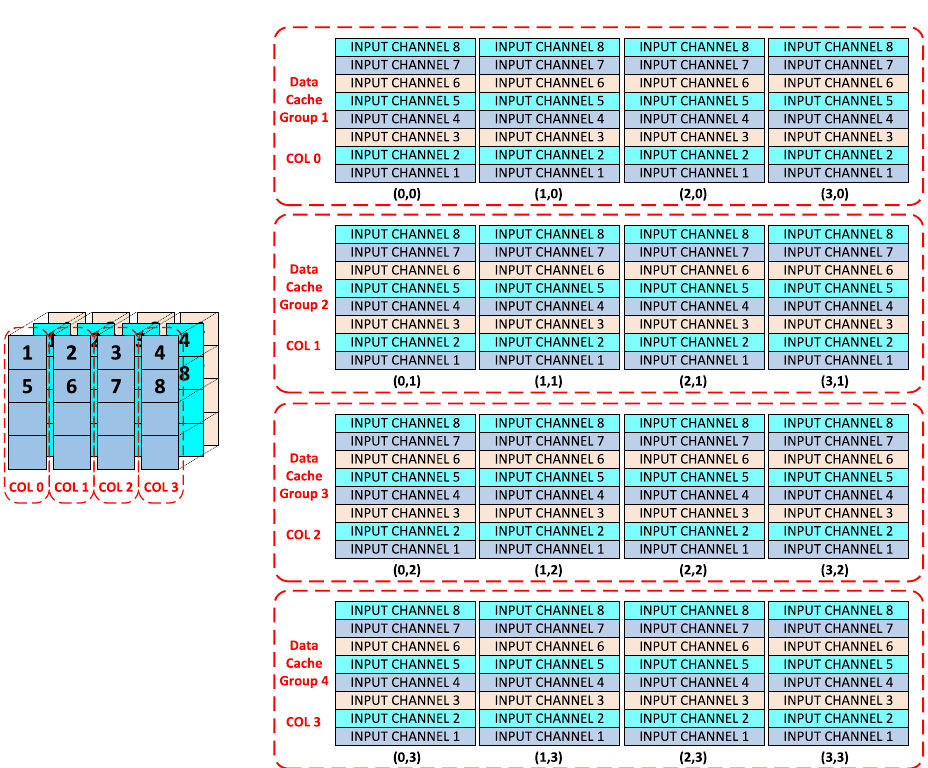
Figure 7. Computational kernel input data